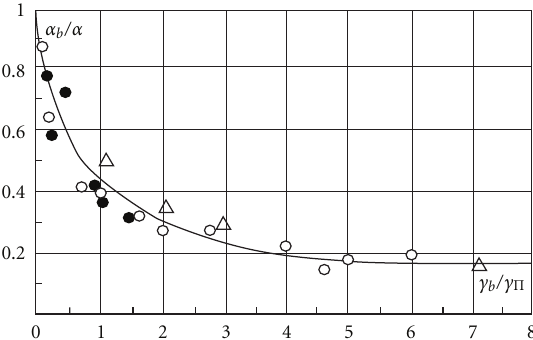
Figure 1: Relative variation of the heat transfer coe ffi cient during condensation as a function of air content in steam (subscript “b” stands for “air”; subscript “ Π ” stands for “steam”)